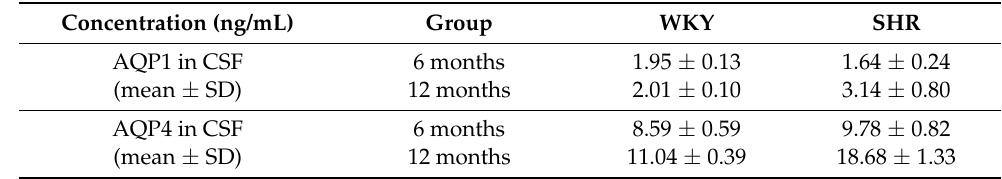
Table 1. CSF levels (ng/mL) of AQP1 and AQP4 in 6 months and 12 months groups of WKY and SHR measured by ELISA expressed as mean ± SD.